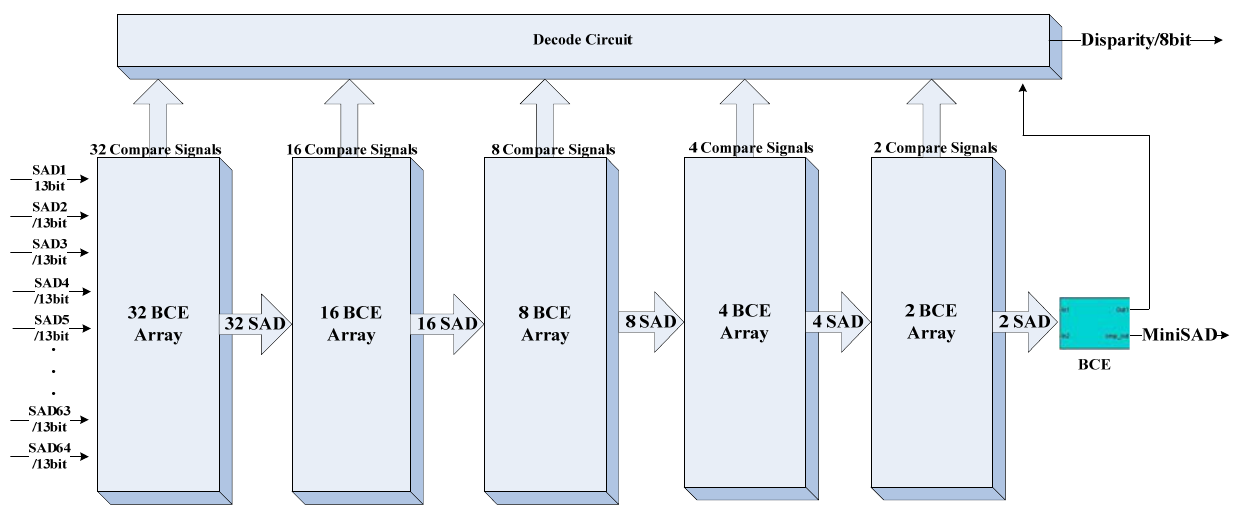
Figure 7. Diagram of the Disparity